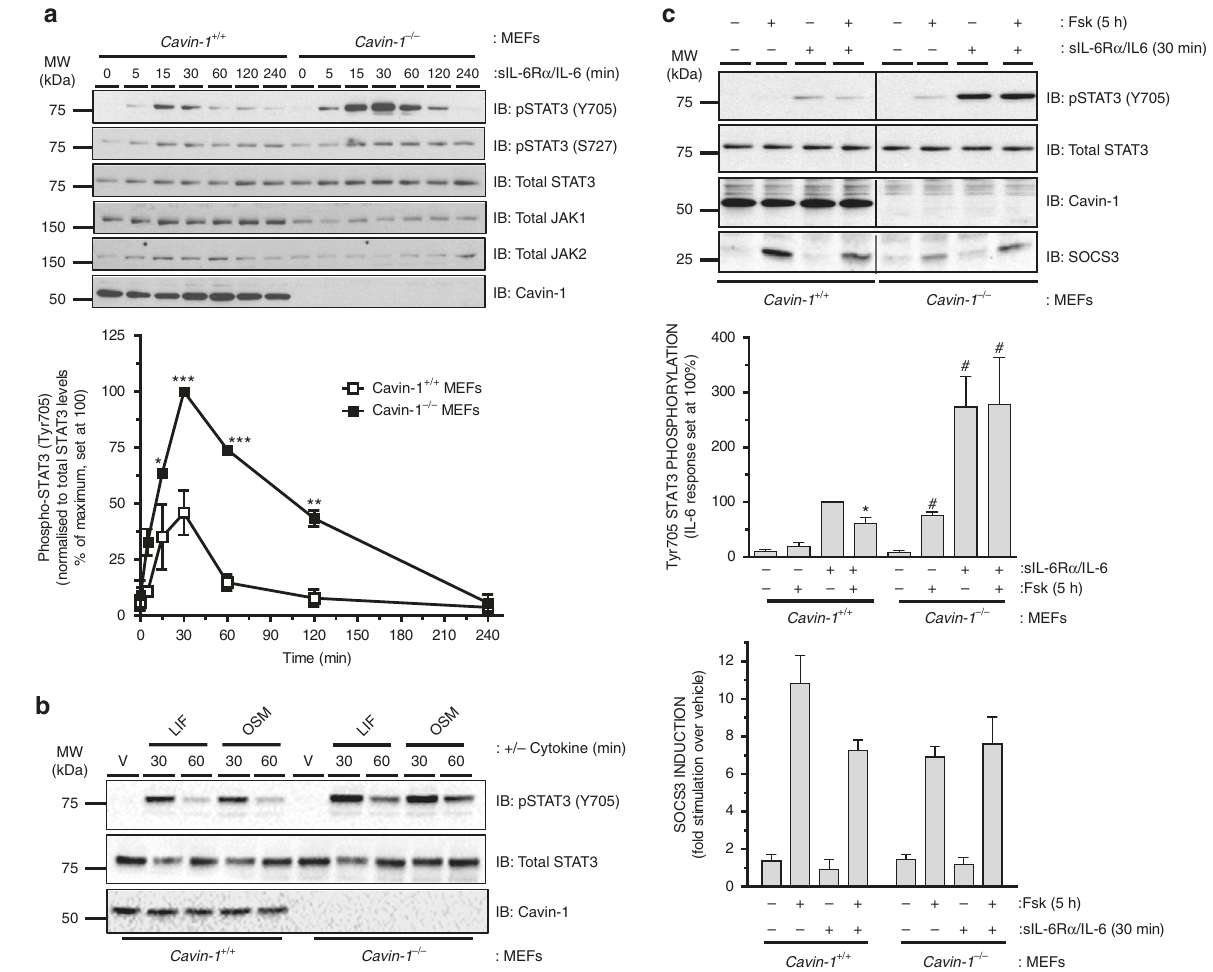
Fig. 8 Cavin-1 limits Tyr705 phosphorylation of STAT3 via SOCS3. a Upper: Protein-equalised soluble cell extracts from cavin-1 + / + and cavin-1 − / − MEFs treated for the indicated times with sIL-6R α /IL-6 (25 and 5 ng ml − 1 ) were fractionated by SDS-PAGE prior to immunoblotting with the indicated antibodies. Quantitation of normalised Tyr705 phospho-STAT3 in cavin-1 + / + and cavin-1 − / − MEFs are presented as mean values ± standard error for N = 3 experiments. * P < 0.05, ** P < 0.01, *** P < 0.001 vs. corresponding treatment in cavin-1 + / + MEFs. b Protein-equalised soluble cell extracts from cavin-1 + / + and cavin-1 − / − MEFs treated for 30 and 60 min with leukaemia inhibitory factor (LIF; 0.5 nM), oncostatin M (OSM; 10 ng ml − 1 ) or vehicle (V) were fractionated by SDS-PAGE prior to immunoblotting with the indicated antibodies. c Upper: WT ( cavin-1 + / + ) and cavin-1 − / − MEFs were pre-incubated with or without Fsk (50 μ M) for 5 h prior to treatment with or without sIL-R α /IL-6 (25 and 5 ng ml − 1 ) for 30 min. Cell extracts were analysed by SDS-PAGE and immunoblotting with the indicated antibodies. Lower: Quantitation of normalised Tyr705 phospho-STAT3 and SOCS3 in cavin-1 + / + and cavin-1 − / − MEFs is presented as mean ± standard error for N = 3 experiments, * P < 0.05 vs. sIL-6R α /IL-6 treatment in cavin-1 + / + MEFs, # P < 0.05 vs. vehicle treatment in cavin-1 − / −